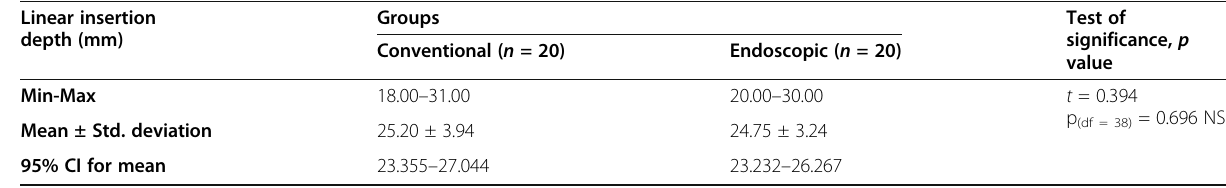
Table 3 The linear insertion depth in millimeters between the studied groups which ranged from 18.00 – 31.00 mm in the conventional group and 20.00 – 30.00 mm in the EAEA group, a difference that was found to be statistically